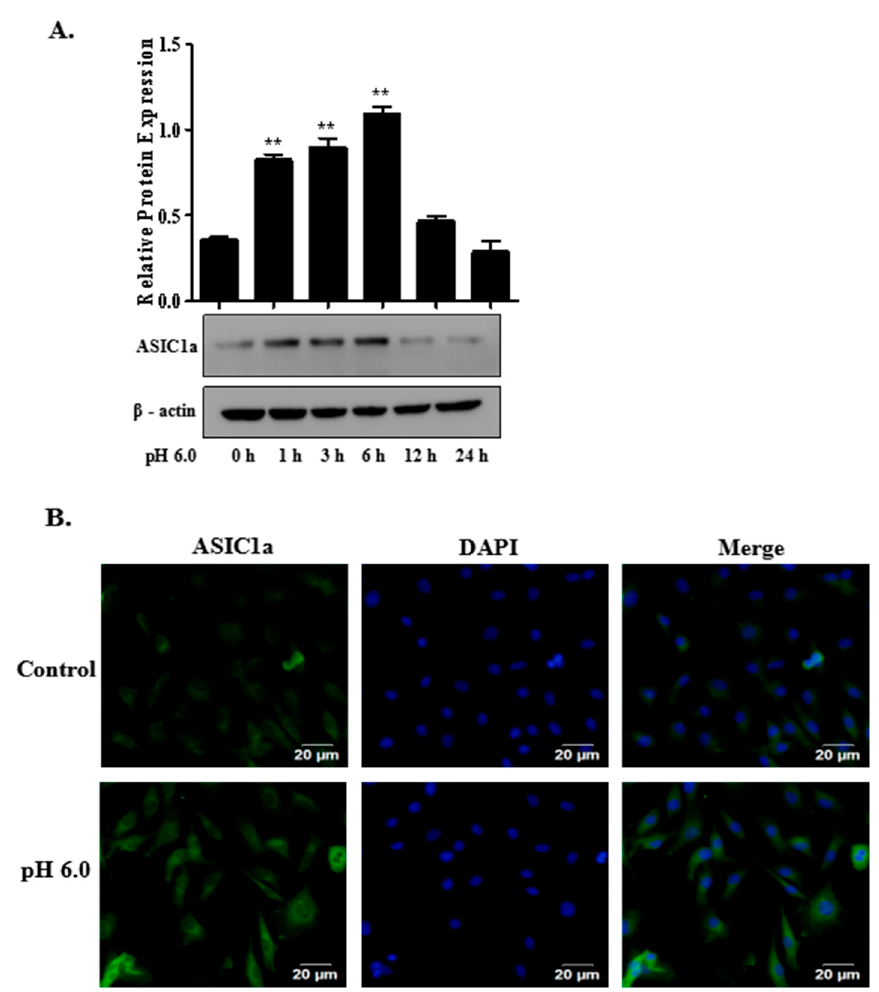
Figure 2. Expression of acid-sensing ion channel 1a (ASIC1a) on rat articular chondrocytes. ( A ) rat articular chondrocytes were treated with extracellular acid (pH 6.0) for different time periods. Cells were then lysed to determine the expression level of ASIC1a by Western blot analysis. Values are presented as mean ± SD of three independent experiments. ** p < 0.01 versus control group; ( B ) representative immunofluorescence analysis was performed on articular chondrocytes using anti-ASIC1a (green) antibody after extracellular acid (pH 6.0) treatment for 3 h. Nuclei were stained with DAPI (blue). Merge contains the combined image of ASIC1a immunostaining and DAPI staining. Scale bar = 20 μ m. Determinations were done in triplicate in three independent cell cultures. DAPI: 4 ′ ,6-diamidino-2-phenylindole, a fluorescent stain that binds strongly to A-T rich regions in DNA.